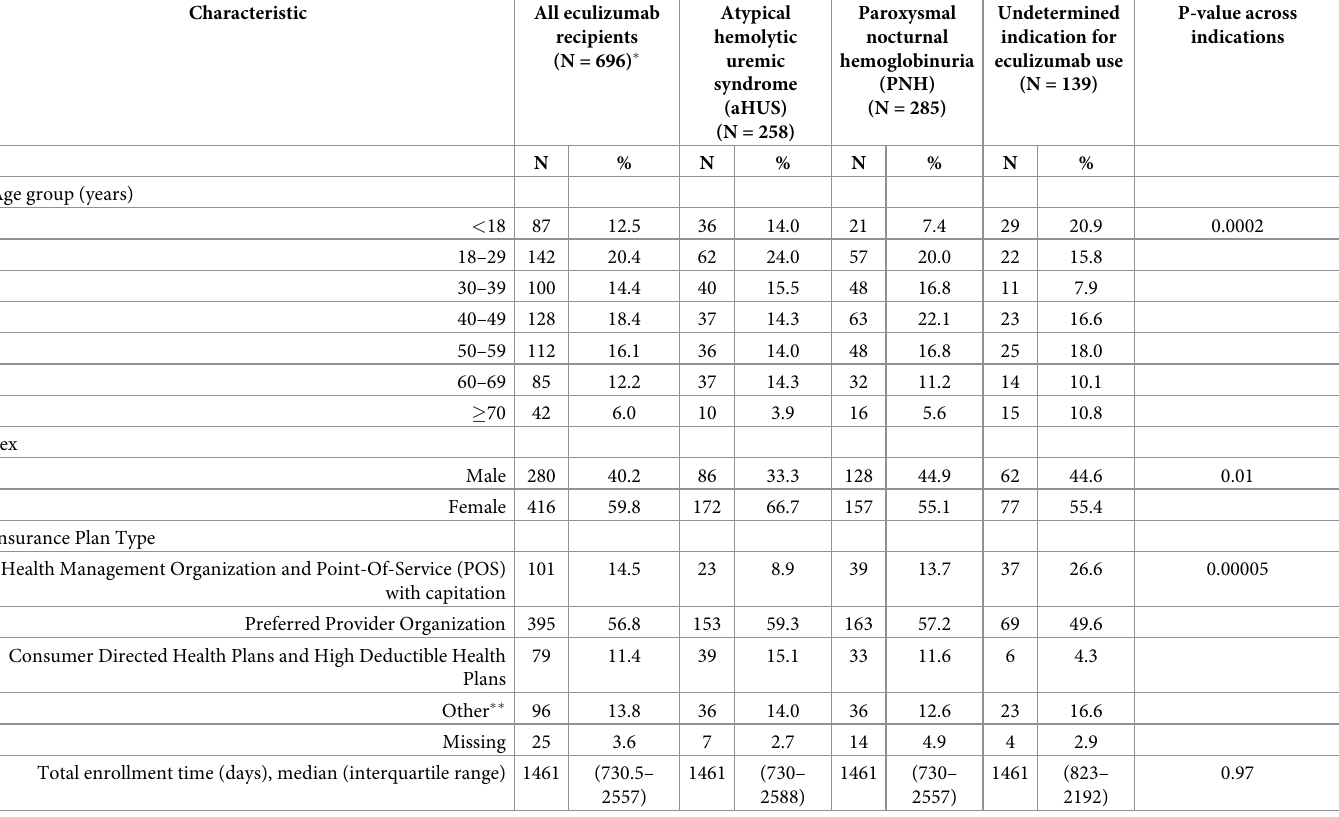
Table 1. Demographic characteristics of eculizumab recipients in the IBM Marketscan Commercial Database, overall and by indication for eculizumab use, 2007– 2017. Characteristic All eculizumab